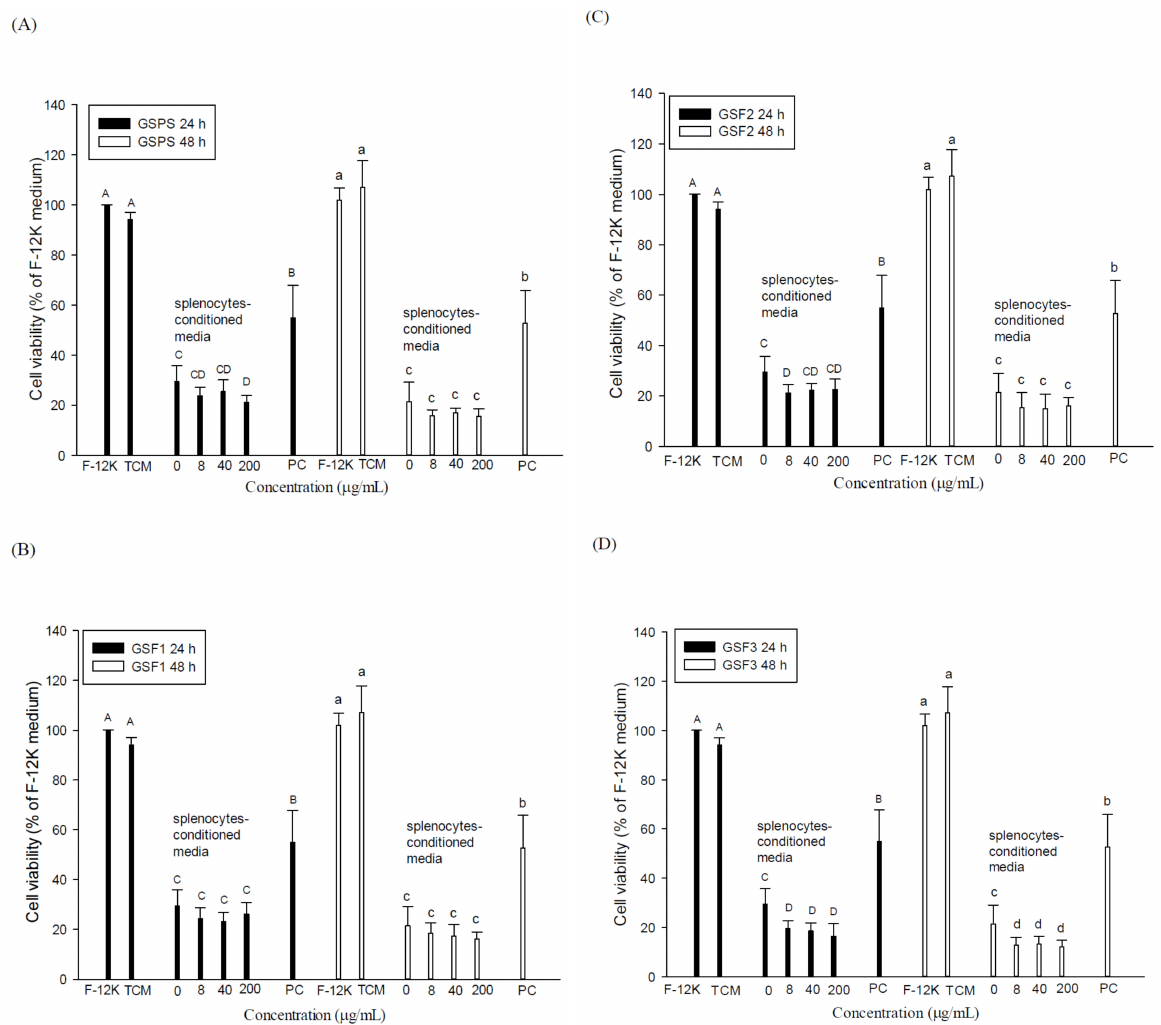
Figure 3. Effects of indirect treatments with splenocyte conditioned media (SCM) cultured with guava seed polysaccharide (GSPS) ( A ), GSF1 ( B ), GSF2 ( C ), and GSF3 ( D ) on PC-3 cell growth. Cells (2 × 10 5 cells/mL) were treated with SCM for 24 and 48 h, respectively. Values are means ± SD (n = 6 biological determinations). Bars in the same plot at the same incubation time not sharing a common letter are significantly different ( p < 0.05) from each other, assayed by one-way ANOVA, followed by Duncan’s multiple range test. SCM, conditioned media of splenocytes cultured with different polysaccharide fractions at different concentrations; PC, positive control (paclitaxel at 2.5 µ